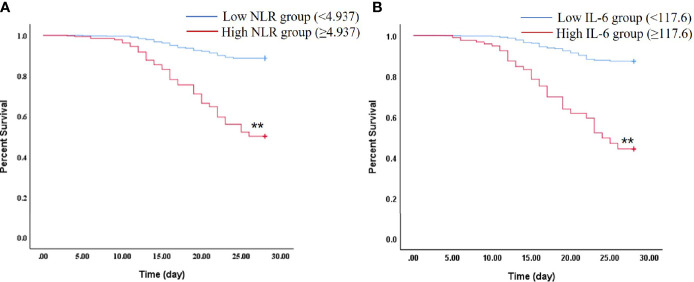
Kaplan–Meier plot showing survival in septic patients grouped by NLR or IL-6 levels. (A) Kaplan–Meier survival curves of 28-day mortality according to NLR levels (log-rank = 0.000). **
P < 0.01 vs Low NLR group. (B) Kaplan–Meier survival curves of 28-day mortality according to IL-6 levels (log-rank = 0.000). **
P < 0.01 vs Low IL-6 group.